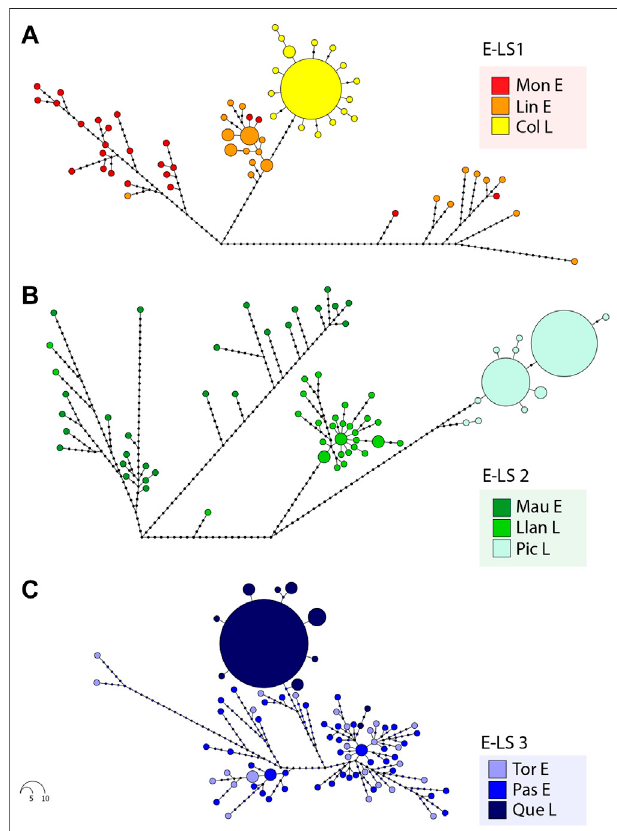
FIGURE 2 | Maximum parsimony haplotype networks in Galaxias maculatus based on mtDNA D-loop sequences from: (A) Estuary-Lake System 1: E-LS 1 (Moncul Estuary: Mon E, Lingue Estuary: Lin E and Colico Lake: Col L); (B) Estuary-Lake System 2: E-LS2(Maullín Estuary: Mau E, Llanquihue Lake: Llan L and Pichilaguna Lake: Pic L); and (C) Estuary-Lake System 3: E-LS3 (Tortel Estuary: Tor E, Pascua Estuary: Pas E and Quetru Lake: Que L). Each haplotype is represented by a coloured circle showing the locality where it was collected. The size of the circles is proportional to the frequency in the sampling